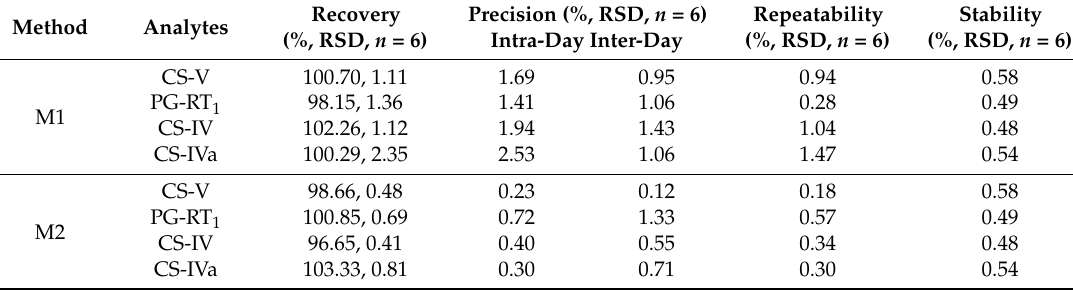
Table 2. The accuracy, precision, repeatability, and stability of Methods 1 and